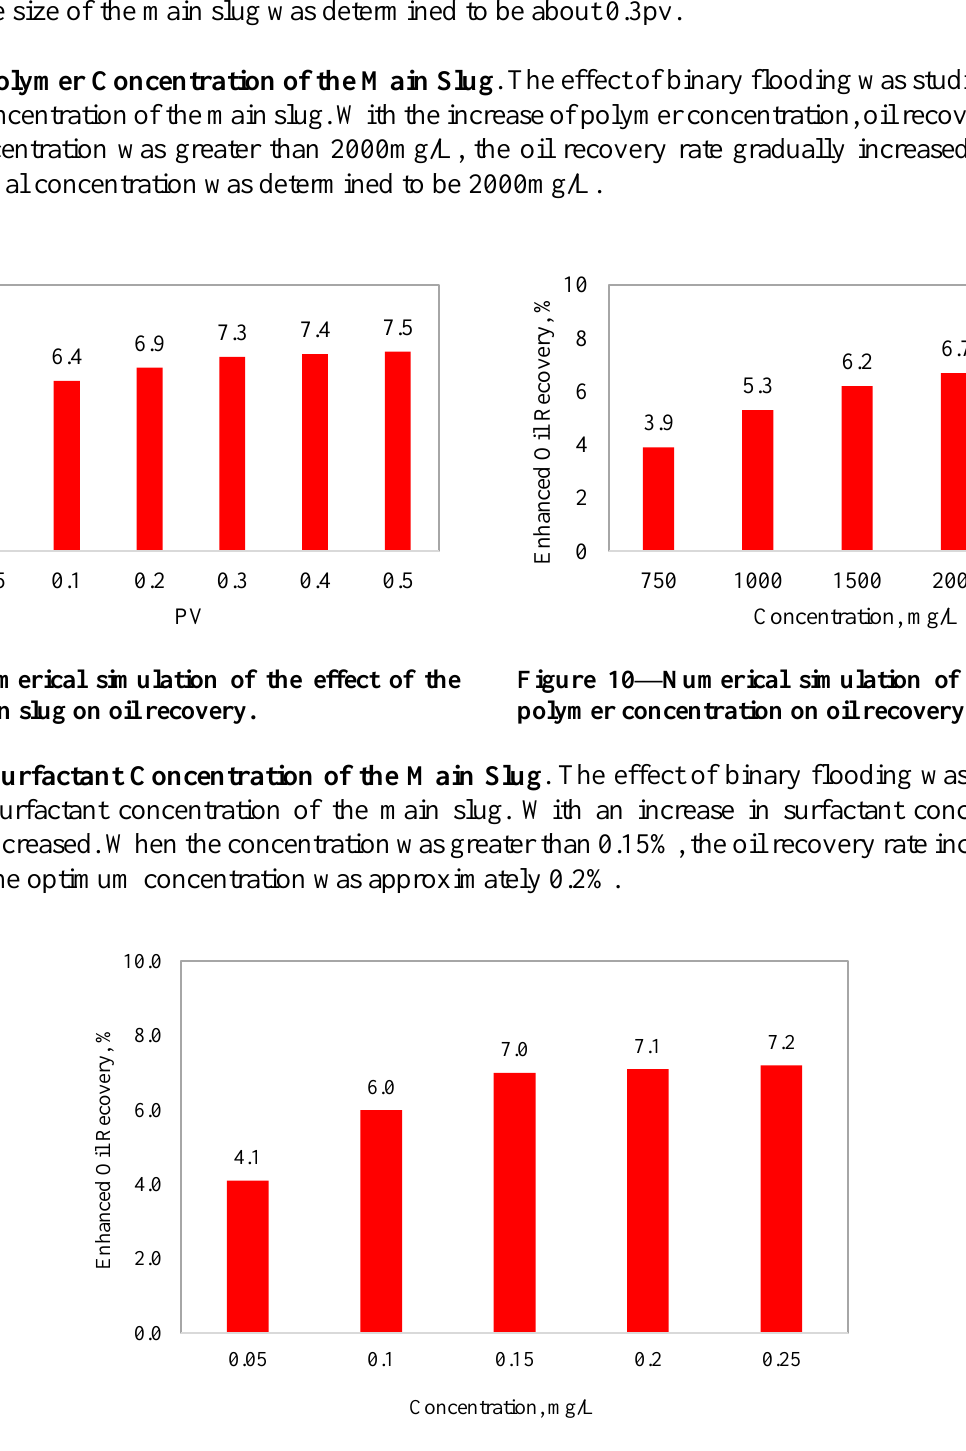
Figure 11—Numerical simulation of the effect of surfactant concentration on oil